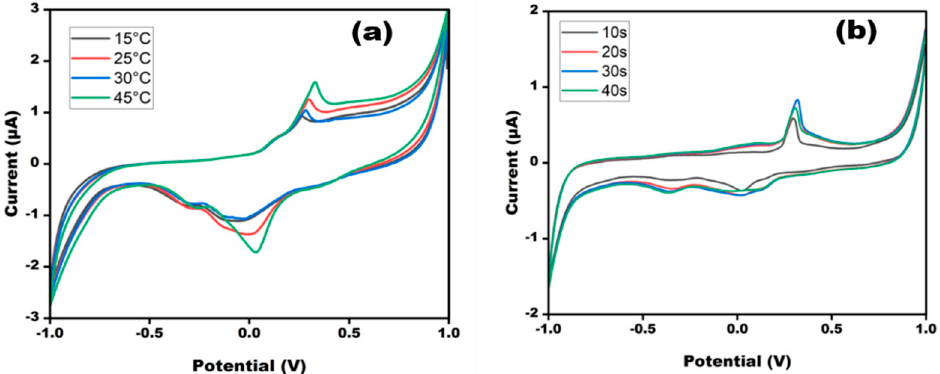
Figure 4. Cyclic voltammetry obtained at DNA probe/AgNPs/PBGs for different ( a ) temperature (15–45 °C) and ( b ) time (10–40 s) in 10 mM methylene blue in 0.1 M KCl at 50 mV s − 1 in the potential range from − 1 V to +1 V.